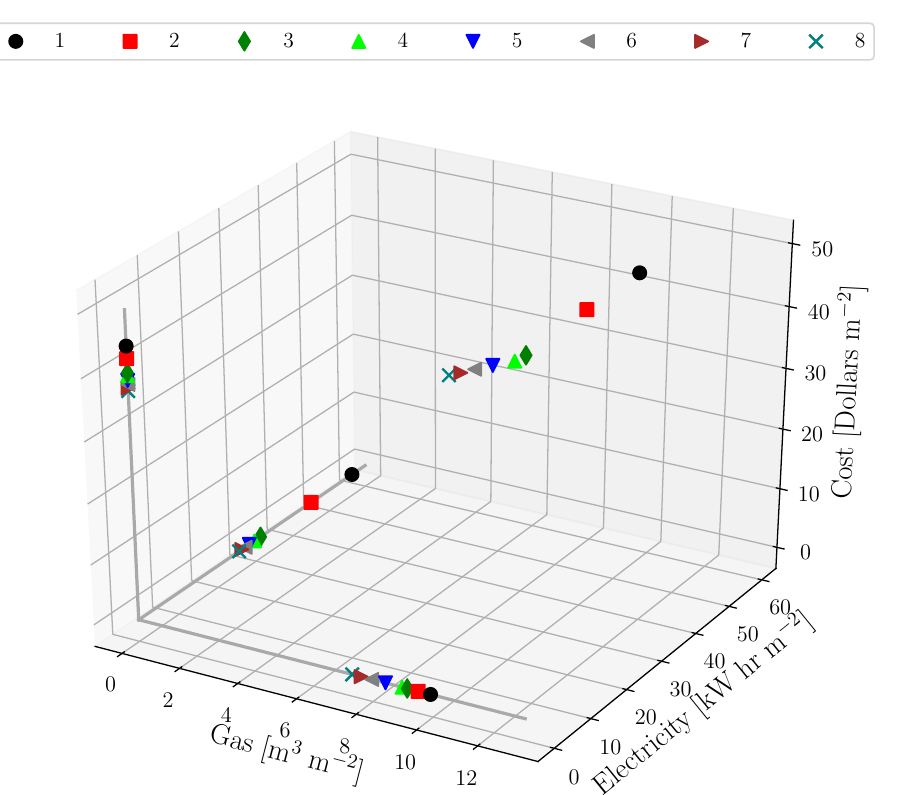
Figure 5. Pareto path of optimization process using 3D visualization showing succession of solutions 1 to 8 with gas consumption, electricity consumption, and cost.